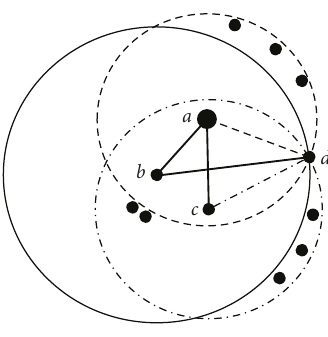
Figure 4: Possible edge crossing in the minimum nearest neighbor- hoods spanning tree